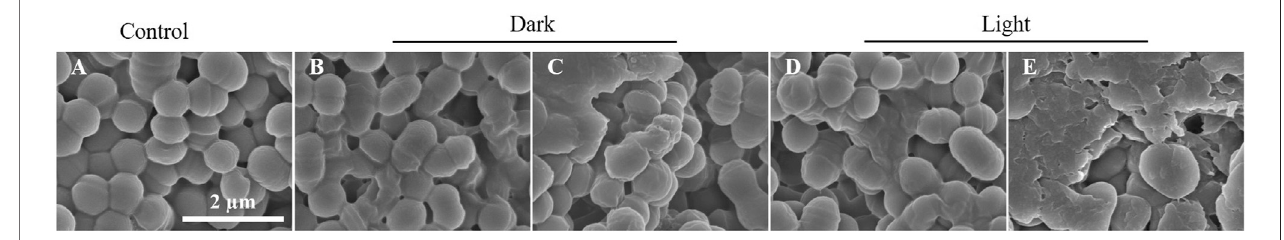
FIGURE5| SEMimagesofGBSincubatedwithorwithoutTBP-1(10 µM). (A) ControlsamplesofGBSincubationwithoutTBP-1. (B,C) GBSincubatedwithTBP- 1 for 10 or 30 min in the dark, respectively. (D, E) GBS incubated with TBP-1 under white light (4.2 mW cm − 2 ) for 10 or 30 min, respectively. Scale bar: 2 µm.